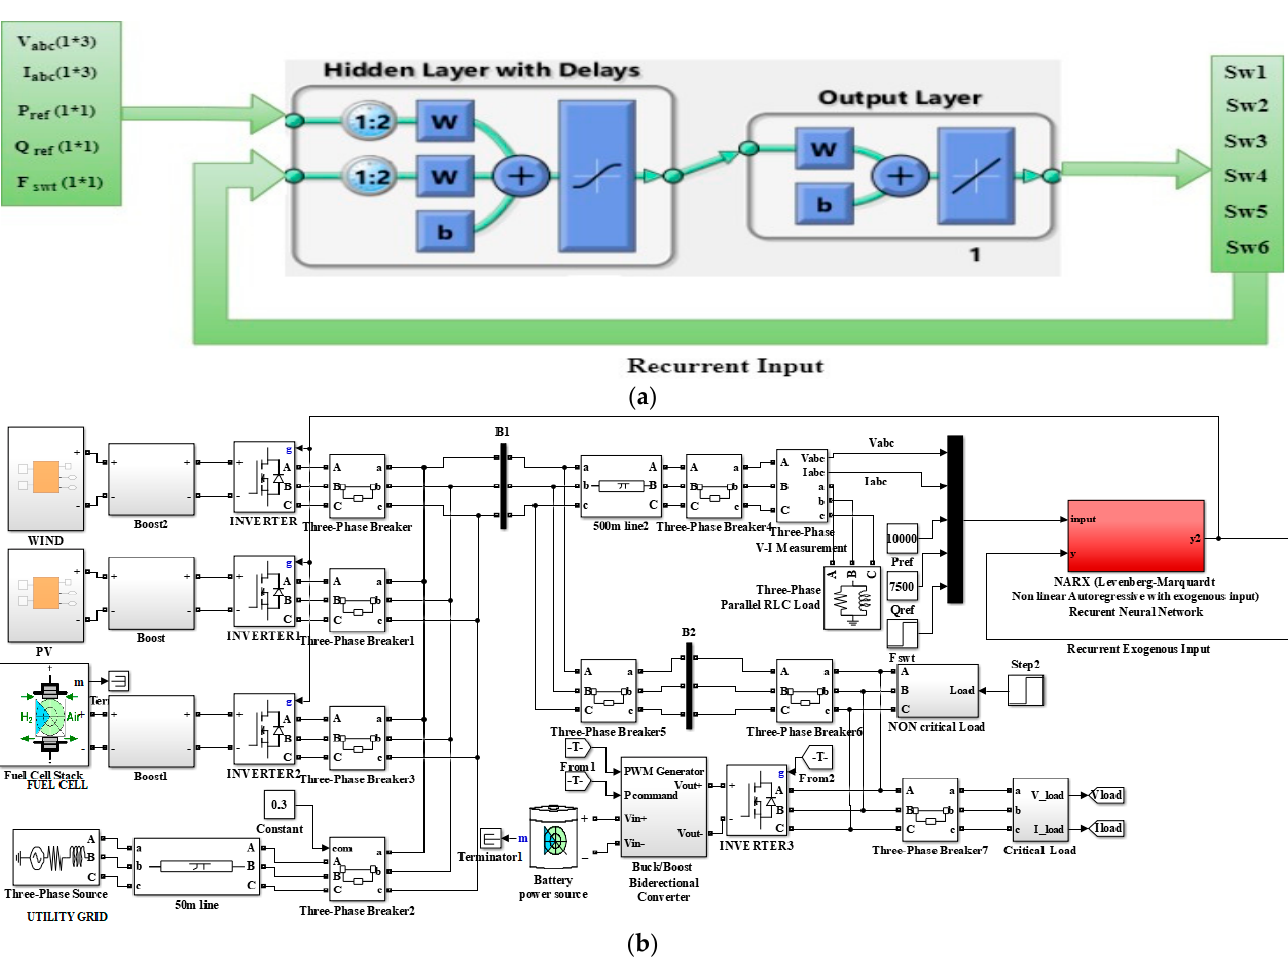
Figure 7. ( a ) A NARX model for the valuation of the PQ in MG system. ( b ) NARX controller linked to Wind, PV, and Fuel Cell (DER1, DER2, and DER3) inverters.